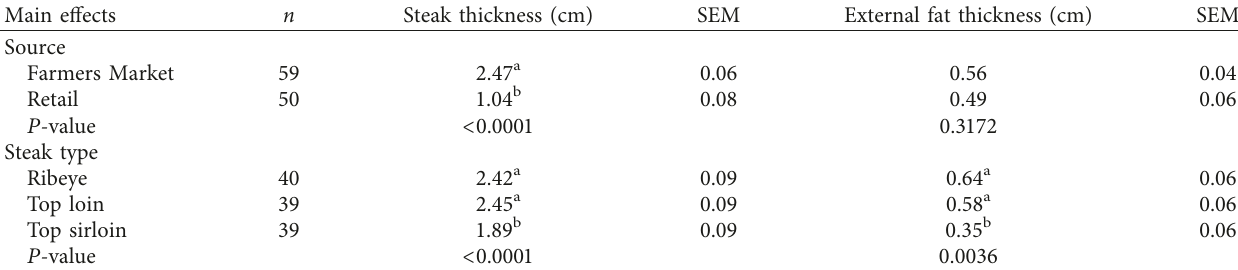
Table 3: Least squares means for steak thickness and external fat thickness by source and steak type main effects.